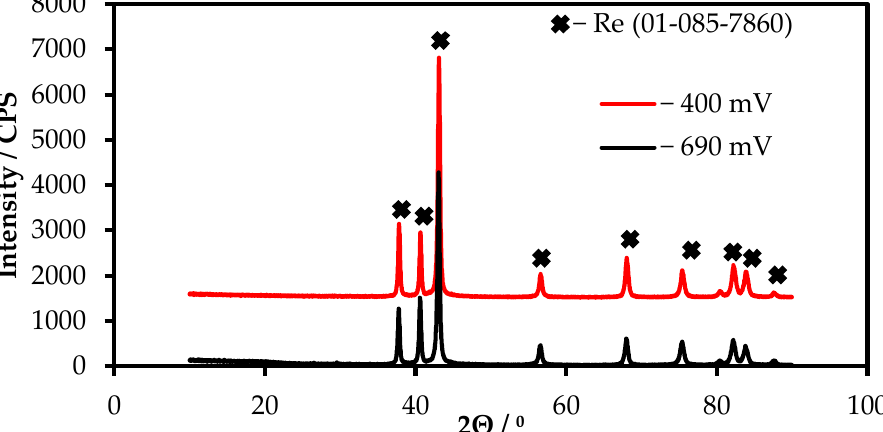
( B ) Figure 8. SEM images of rhenium nanofibers obtained at the potentials of 400 mV ( A ) and at the